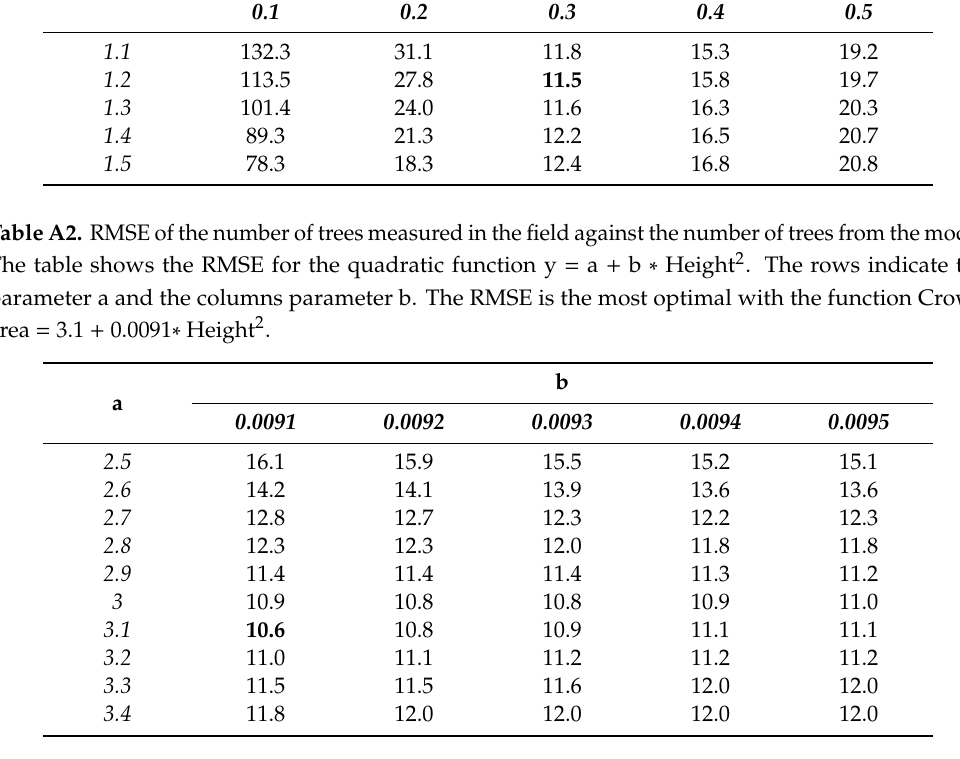
Table A3. The RMSE of predicted tree crown area (m 2 ) as a linear or quadratic function of tree height (H). The table contains the RMSE values for the eight most common tree species on the Veluwe. The RMSE is calculated to determine whether linear or quadratic tree crown area–height relationship fits the data the best. The linear function showed to be the most robust and was therefore